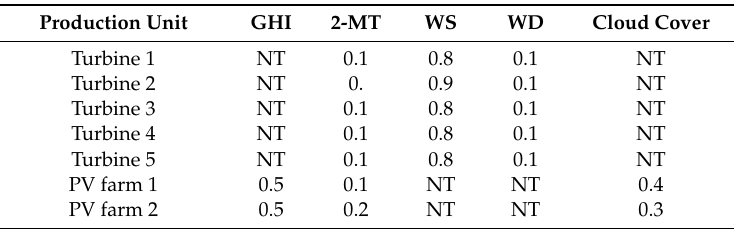
Table 1. Weights of the meteorological predictors for each wind turbine and solar farm. The predictors indicated by NT were not tested. WS: wind speed; WD: wind direction; 2-M T: 2-m temperature; PV: